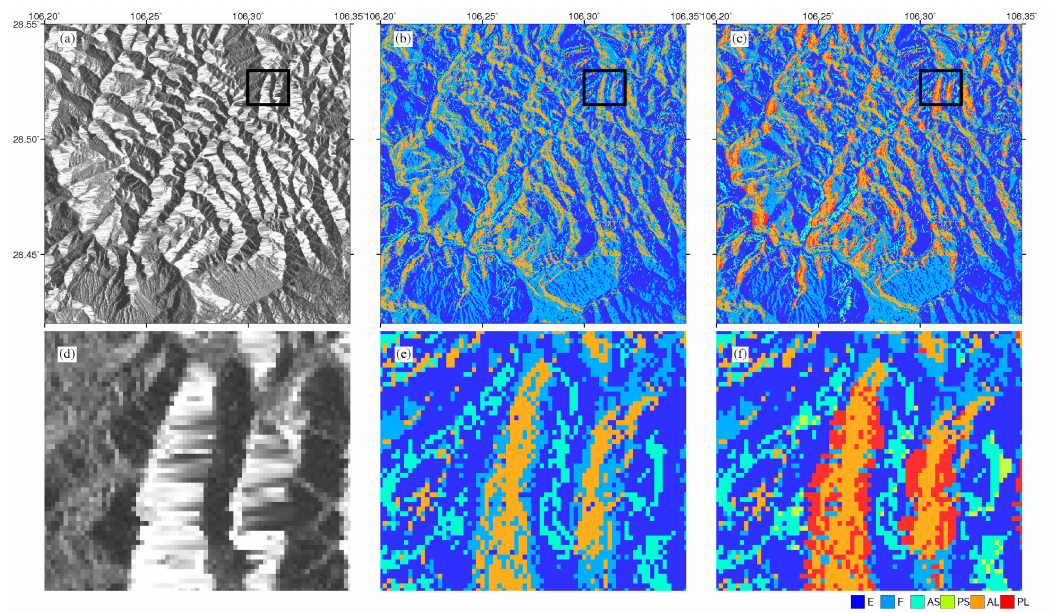
Figure 4. Geometric distortions in the ALOS ascending image. ( a , d ) display the intensity image; ( b , e ) display the SDG map derived by the F-ALS method; ( c , f ) display the SDG map derived by the P-NG method. E: Resolution-Enhancing; F: Foreshortening; AS: Active Shadow; PS: Passive Shadow; AL: Active Layover; PL: Passive Layover.